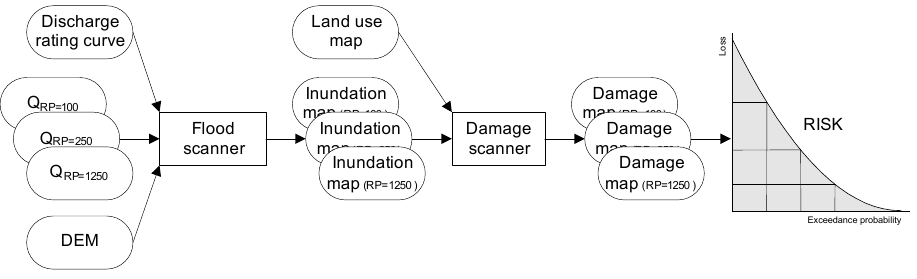
Fig. 2. Overview of the methods used in the study. Floodscanner is a model developed for this research that produces maps of inundation depth per grid-cell. Damagescanner (Aerts et al., 2008; Klijn et al., 2007) estimates the economic damage per grid-cell. Risk, in terms of expected annual damage, is calculated by approximating the area under the resulting exceedance probability-loss